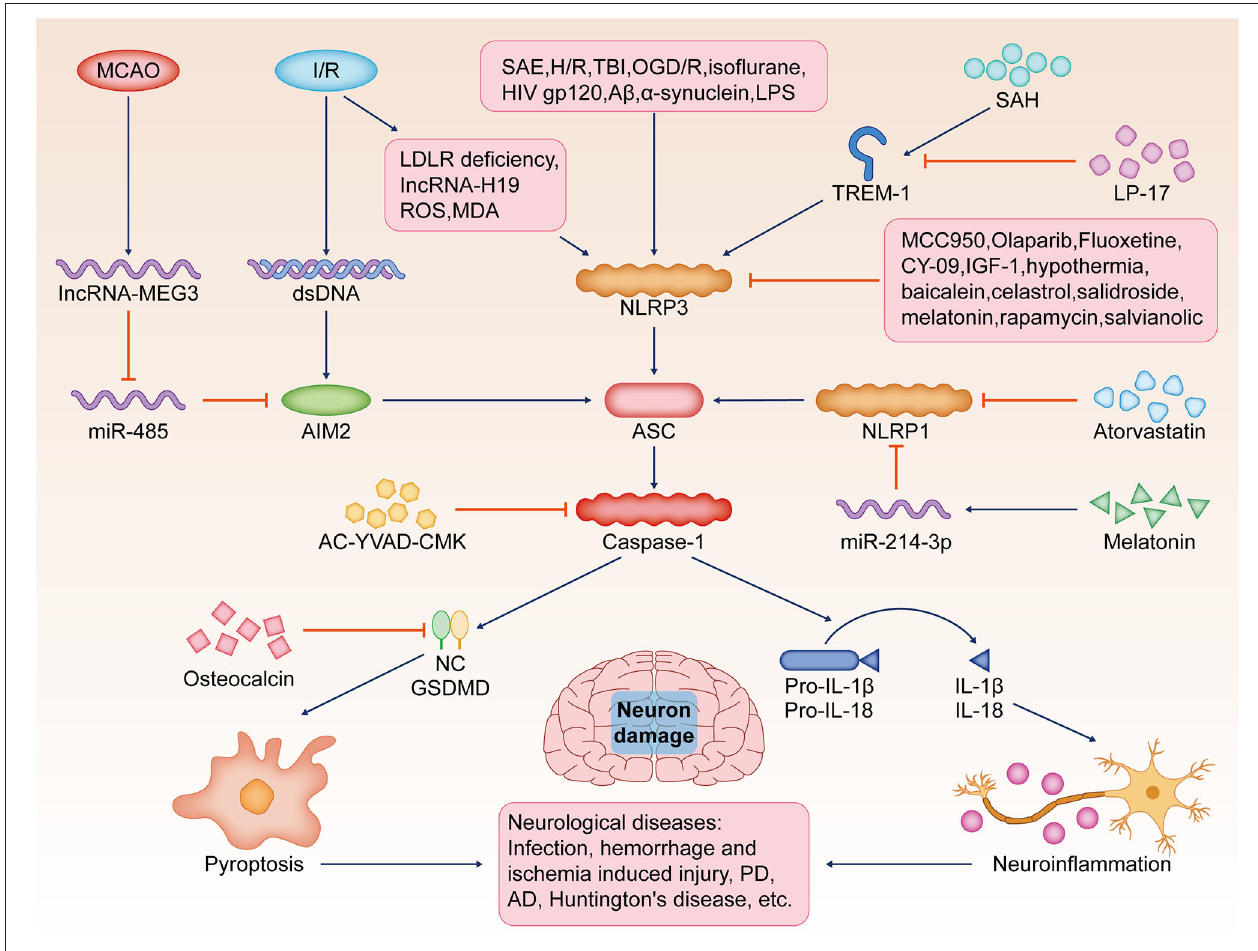
FIGURE 2 | Pyroptosis, neuron damage, and neurological diseases. Pyroptosis is a potential target for the pathological mechanism and treatment of various neurological diseases, such as brain infection, hemorrhagic/ischemic injury, Huntington’s disease, AD, or PD. SAE, H/R, TBI, OGD/R, isoflurane, A β , LPS, or HIV-gp120 stimulate NLRP3-mediated pyroptosis, resulting in increased caspase-1 activity in the brain and the release of a large number of pro-inflammatory cytokines, such as IL-1 β and IL-18. I/R induces the release of dsDNA and activates AIM2 to induce neuronal pyroptosis. In addition, reduced LDLR, IncRNA-H19, ROS, and MDA lead to severe neuronal pyroptosis by activating the NLRP3/caspase-1/GSDMD signaling pathway. SAH, TREM-1-activated microglial pyroptosis induced by NLRP3 inflammasome, and the use of TREM-1 inhibitor LP17 significantly ameliorated this damage. MCAO, induced by lncRNA MEG3, promotes AIM2-induced pyroptosis by sponging miR-485. NLRP3 inhibitor MCC950, olaparib, fluoxetine, CY-09, IGF-1, hypothermia, baicalein, celastrol, salidroside, melatonin, rapamycin, and salvianolic acid significantly reduce neuronal injury by inhibiting pyroptosis. AC-YVAD-CMK inhibits caspase-1 activation. Atorvastatin and melatonin inhibit NLRP1 expression. Osteocalcin inhibits the activation of GSDMD, thereby inhibiting pyroptosis. SAE, sepsis-associated encephalopathy; H/R, hypoxia/reoxygenation; TBI, traumatic brain injury; OGD/R, oxyglucose deprivation and reoxygenation; A β , amyloid β ; LPS, lipopolysaccharide; NLRP3, the nucleotide-binding oligomerization domain (NOD)-like receptor protein 3; (IL)-1 β , interleukin; AD, Alzheimer’s disease; PD, Parkinson’s disease; I/R, ischemia-reperfusion; dsDNA, double-stranded DNA; AIM2, the absent in melanoma 2; LDLR, the low-density lipoprotein receptor; ROS, reactive oxygen species; MDA, malondialdehyde; GSDMD, gasdermin D; SAH, subarachnoid hemorrhage; TREM-1, trigger receptor expressed on myeloid cells 1; MCAO, middle cerebral artery occlusion; lncRNA MEG3, long non-coding RNA maternally expressed gene 3; IGF-1, insulin-like growth factor 1; ASC, the adapter protein apoptotic speck-like protein containing